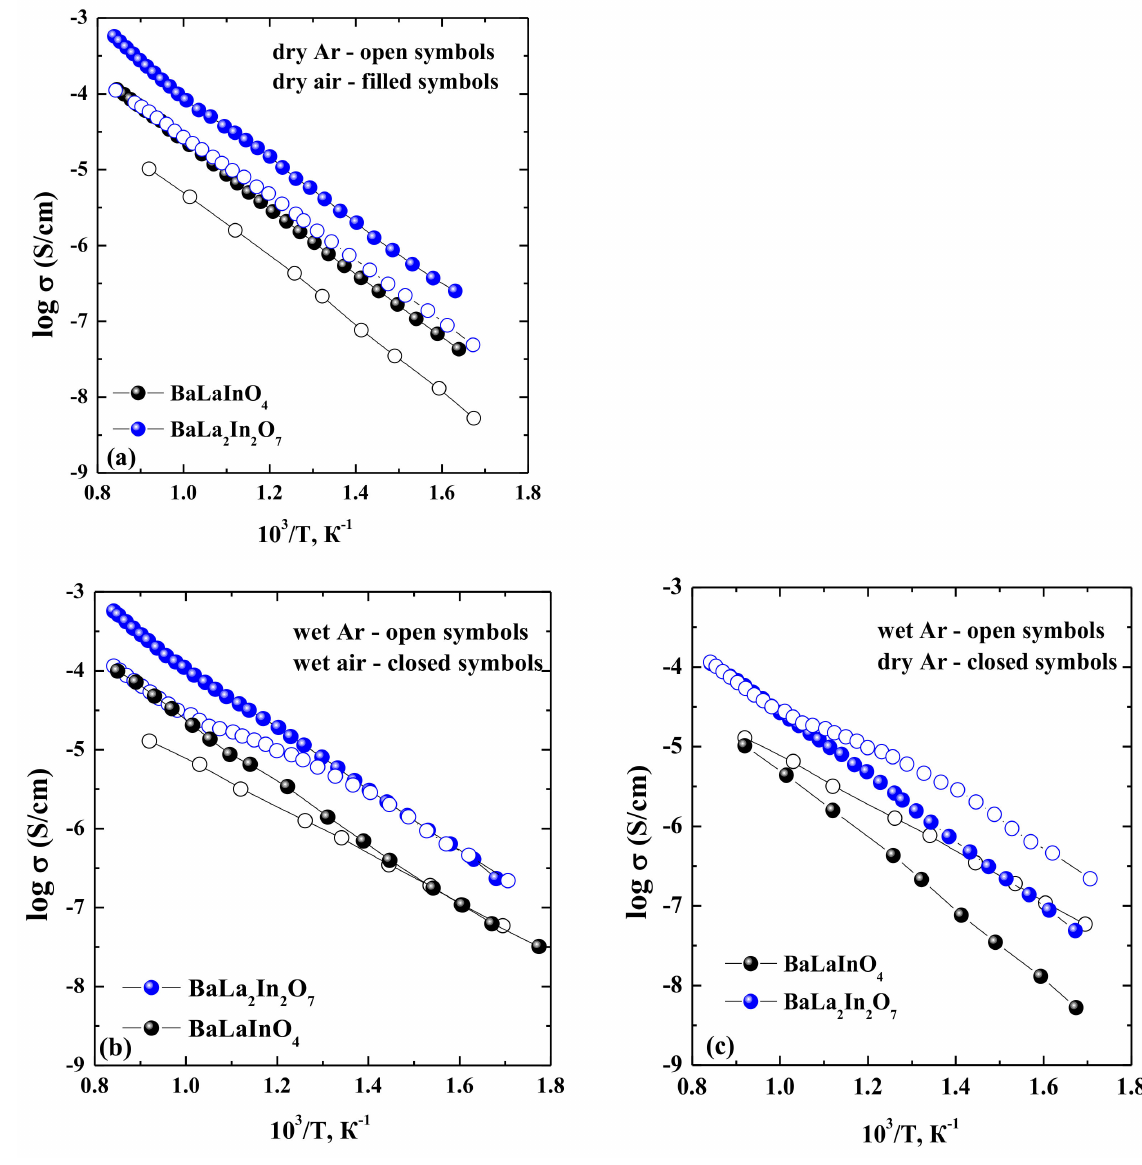
Figure 4. The temperature dependencies of conductivity of BaLa 2 In 2 O 7 (blue symbols) and BaLaInO 4 (black symbols) [29] obtained dry Ar (open symbols) and dry air (closed symbols) ( a ), wet Ar (open symbols) and wet air (closed symbols) ( b ), wet Ar (open symbols), and dry Ar (closed symbols) ( c